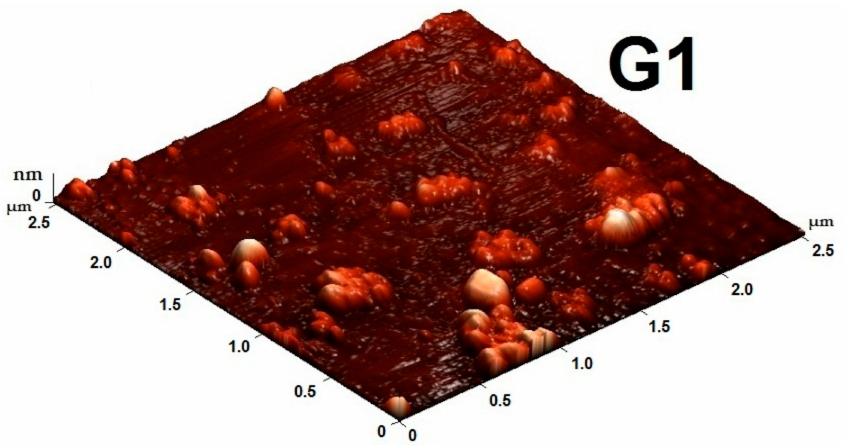
Figure 4. Three-dimensional (3D) AFM images of SiO 2 NPs (sample G0) and silica-gentamicin nanostructured solution (sample G1) deposited on glass substrates.